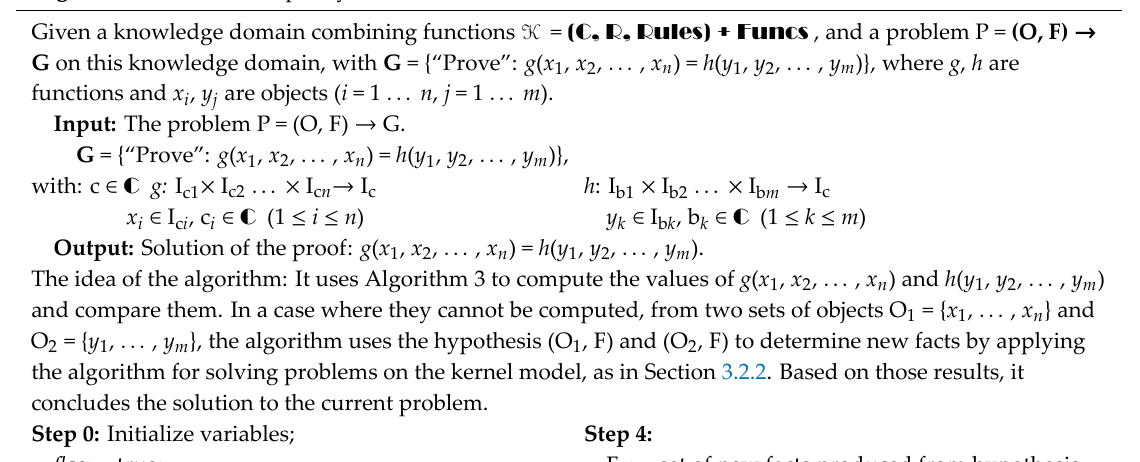
Algorithm 4. Prove the equality between two